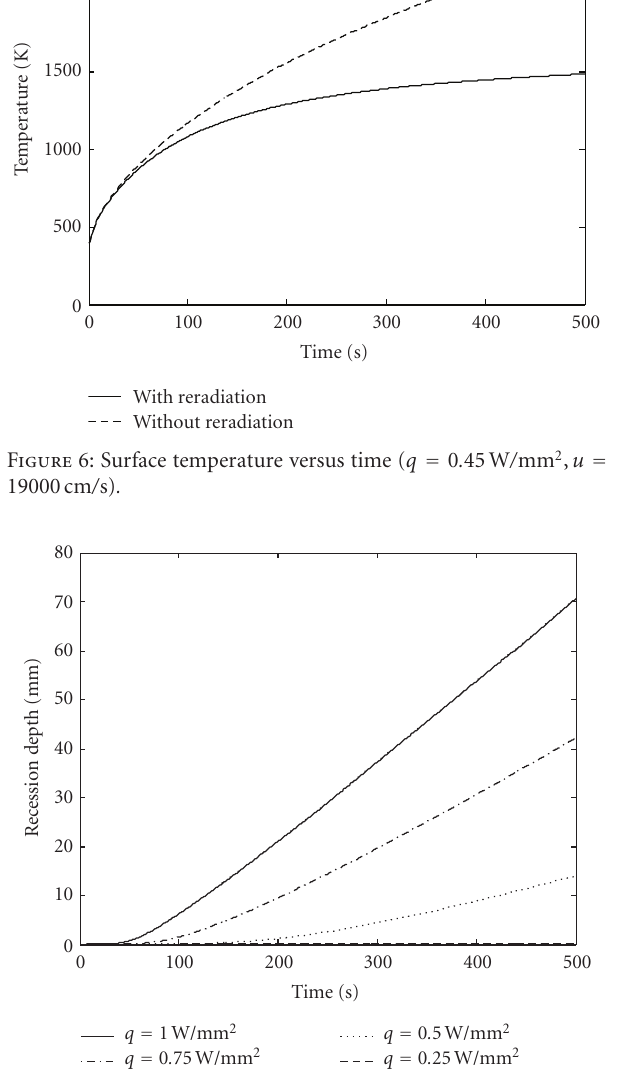
Figure 9: Recession depth at di ff erent altitudes ( q = 0 . 45W / mm 2 )